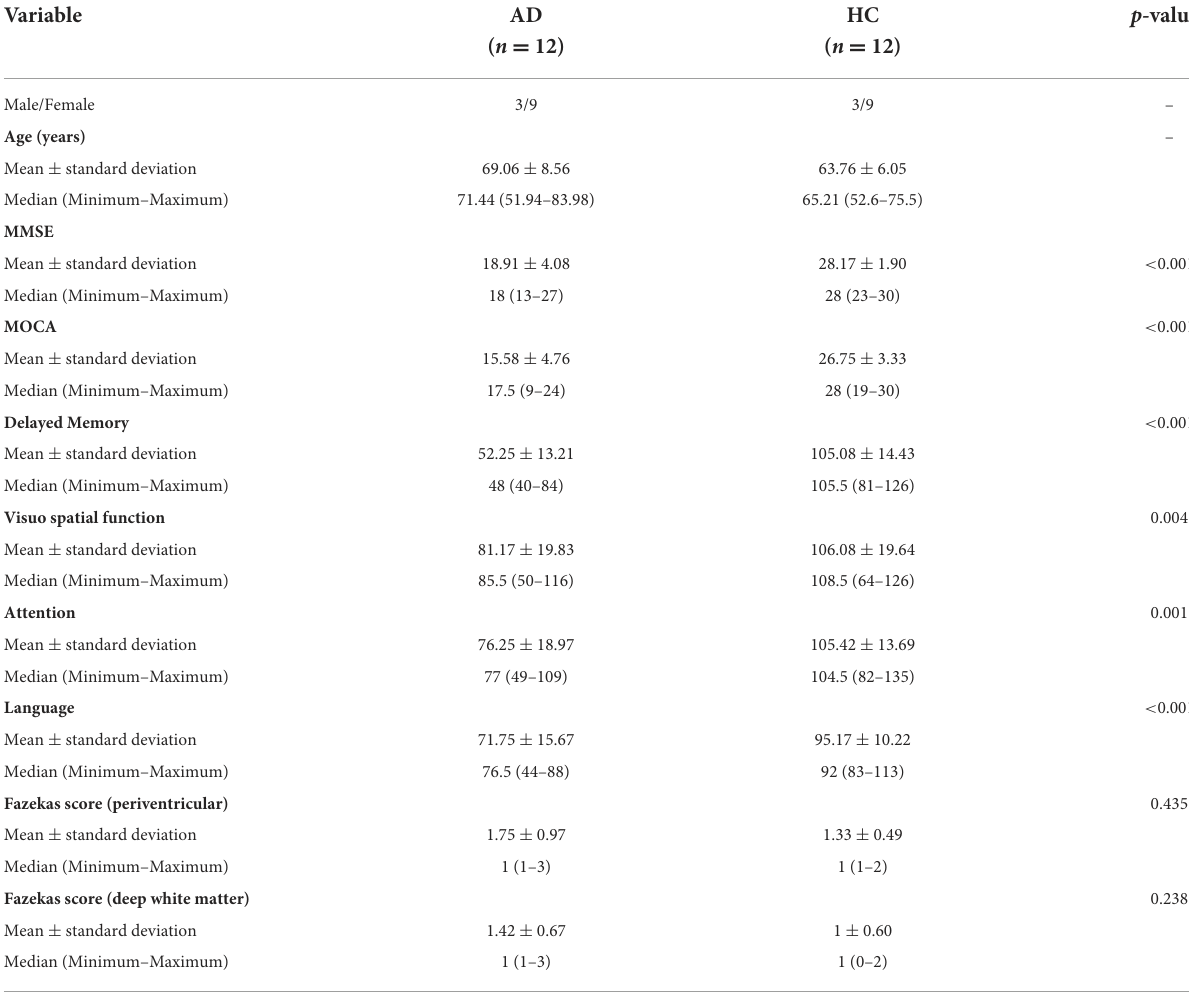
TABLE 2 Clinical demographics of the subjects in the